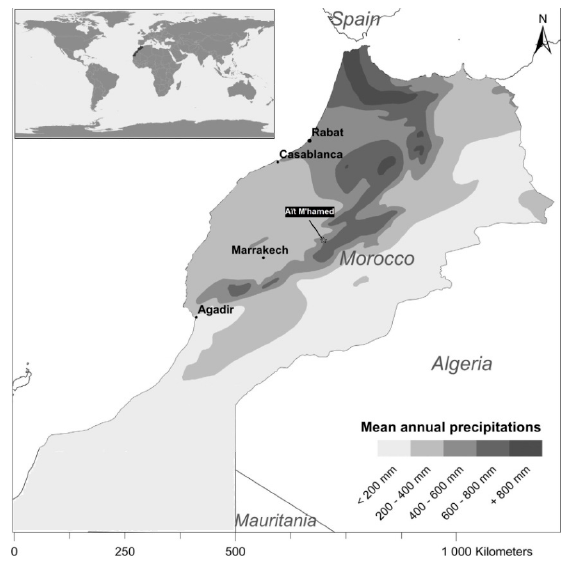
Figure 2. Localization of the study area.